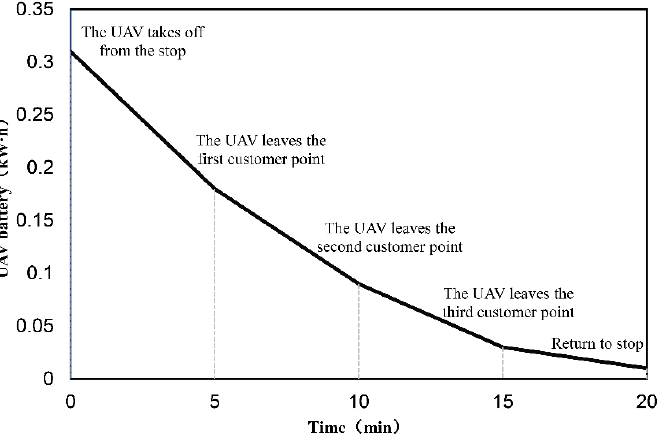
Figure 2. Energy-consumption process of an UAV carrying three packages for